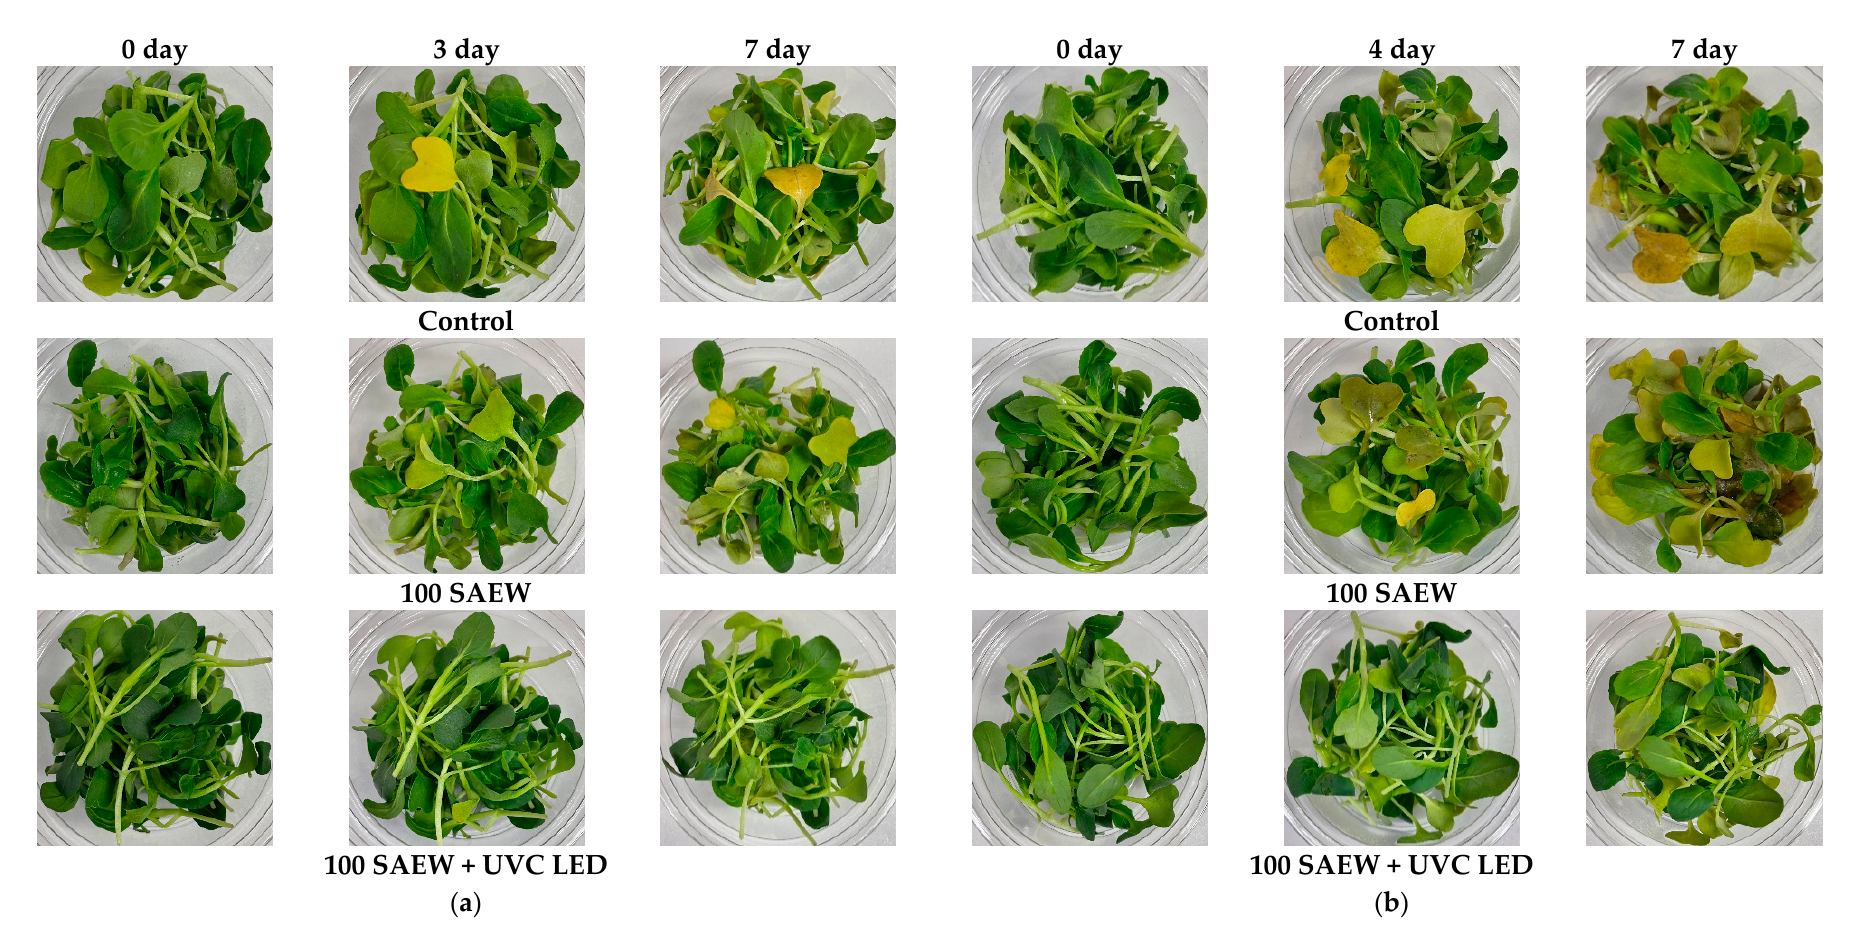
Figure 6. Visual appearance of baby leaves stored for 7 days at ( a ) 10 and ( b ) 15 °C. Control, no extra wash with sanitizer; 100 SAEW, aerosolization with 100 ppm SAEW; 100 SAEW + UVC LED, aerosolization with 100 ppm SAEW and UVC LED irradiation (275 nm) for 3 min.